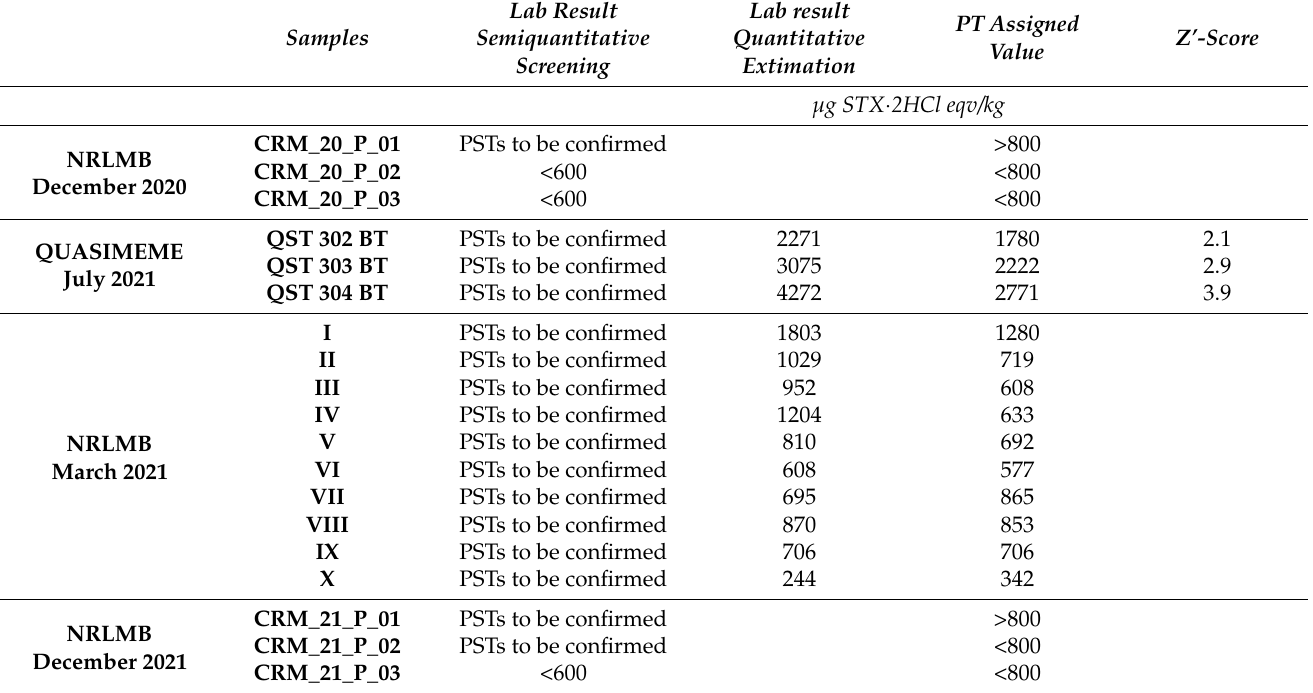
Table 2. PSTs screening method proficiency tests (PTs)